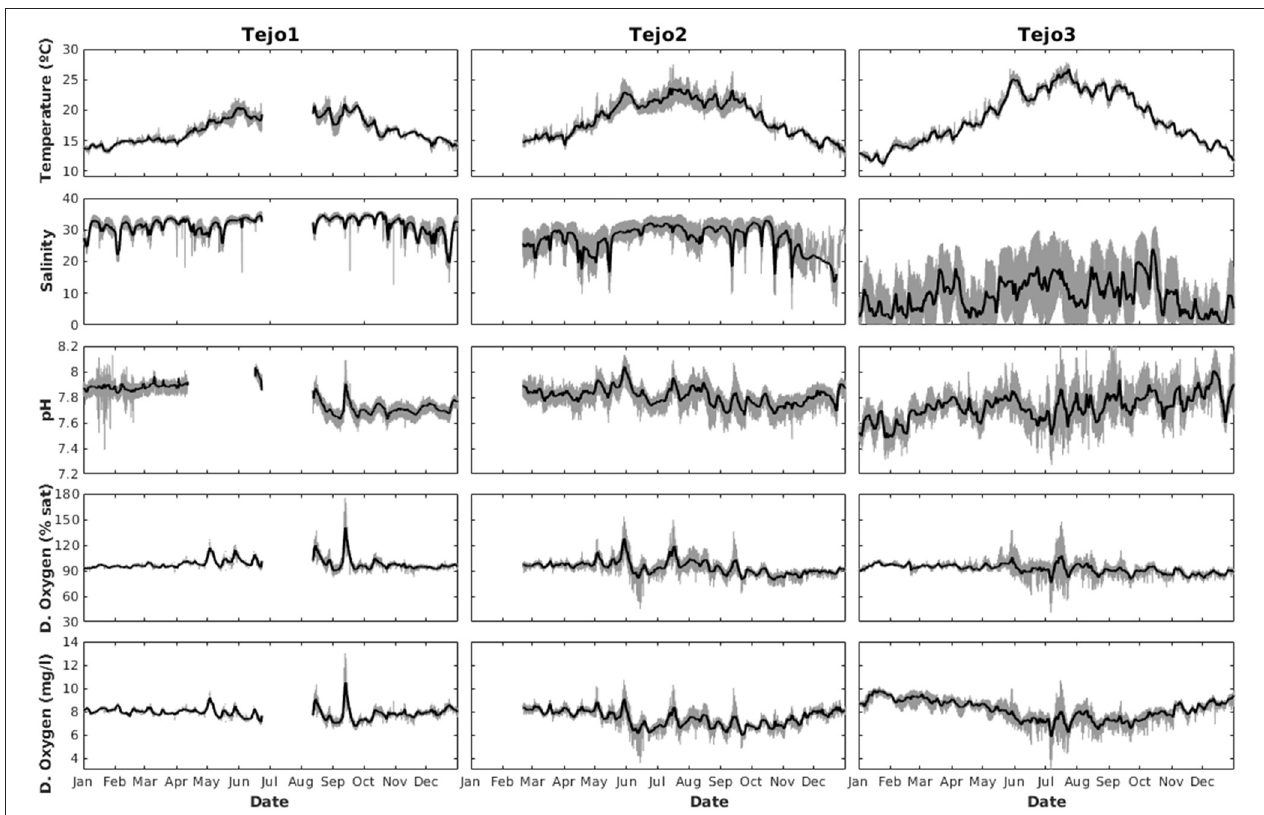
FIGURE 2 | Time-series of Temperature ( ◦ C), Salinity, pH and Dissolved Oxygen (sat% and mg/l) at the Tejo Estuary (gray lines) and its 24h running-mean (black